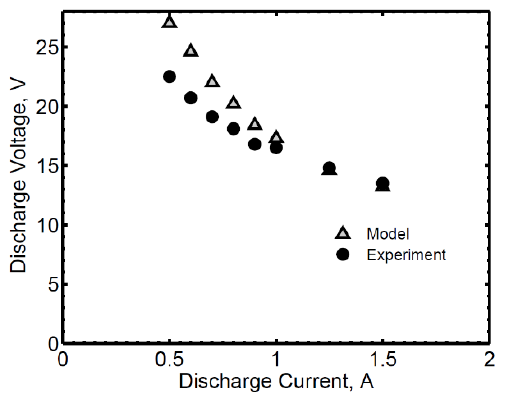
Figure 8. Electrical characteristics comparison between the model and experiment at 0.1 mg/s Xe.